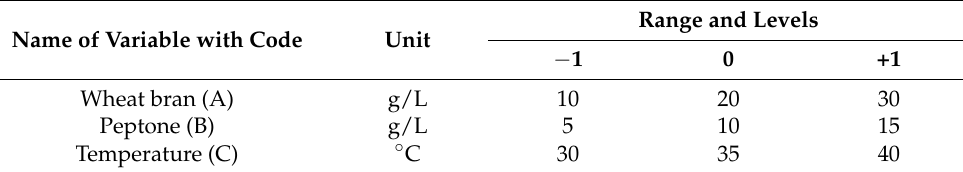
Table 1. Variables optimized by BBD for PHB production.